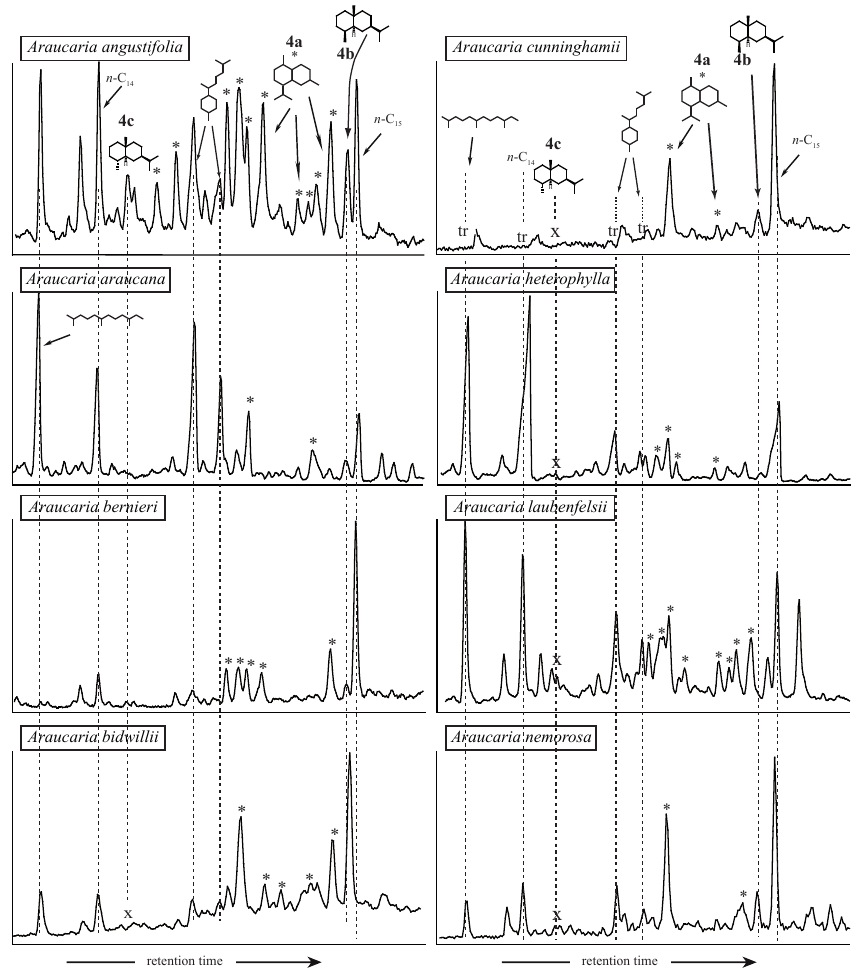
Fig. 2. Partial chromatograms (sesquiterpenoids retention time window) of aliphatic fraction of pyrolysates of Araucaria species. The mass spectra of 4a, 4b, and 4c are given in Fig. 4. x : absence of compound; tr: at trace level; ∗ : cadalane-type